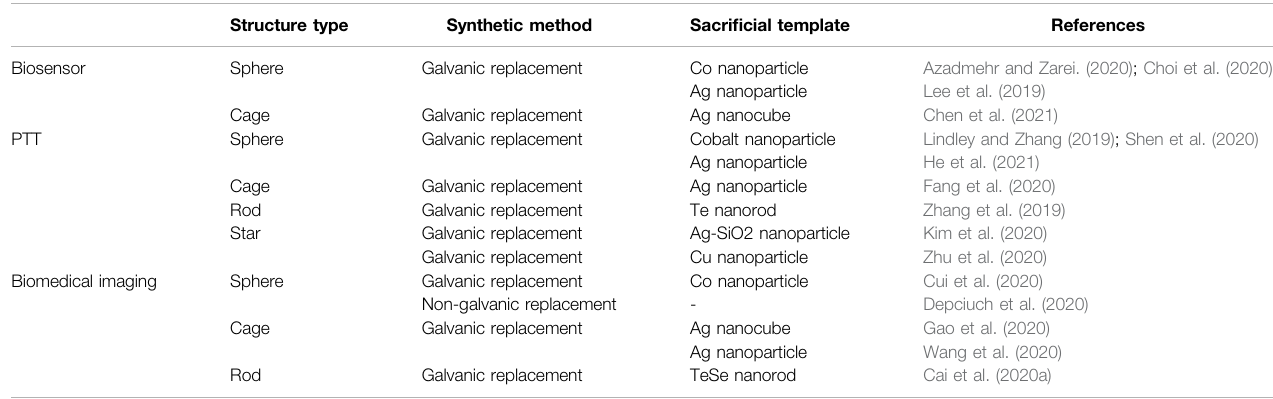
TABLE 1 | Summary of recent studies in hollow gold nanostructures for biomedical